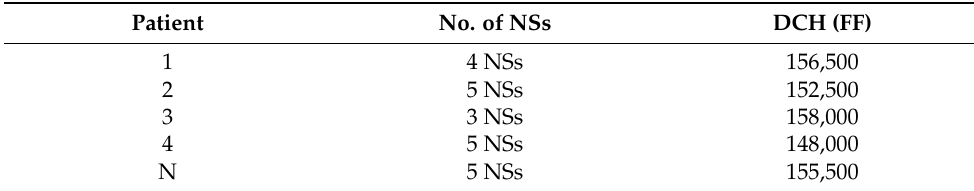
Table 7. The best individual found in case 2 for the dataset [37] and different patients. Patient No. of